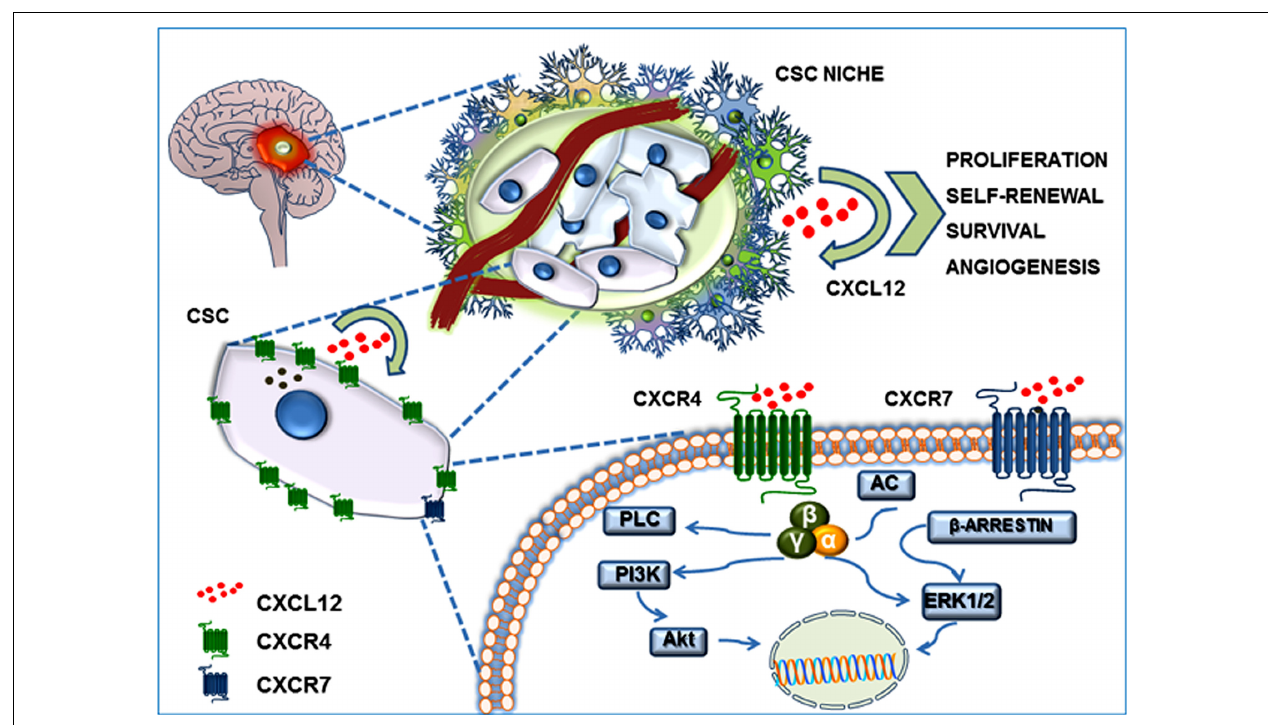
FIGURE 2 | CXCL12/CXCR4–CXCR7 system in the GBM CSC niche. GBM CSC niche is a discrete microenvironment within the tumor mass. It is composed of a heterogeneous cell population that generally includes blood vessels, tumor cells, CSCs, extracellular matrix components, and a gradient